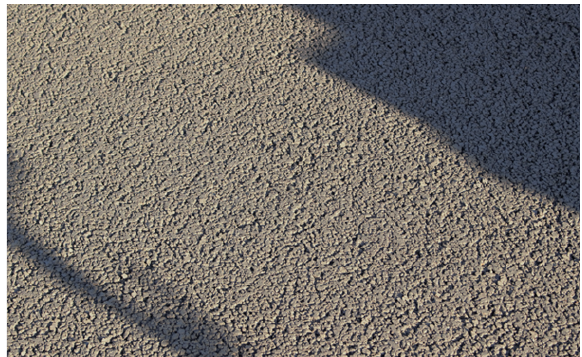
Figure 4. Detail of pervious concrete surface with D max = 8 mm. Figure 5. Detail of pervious concrete surface with